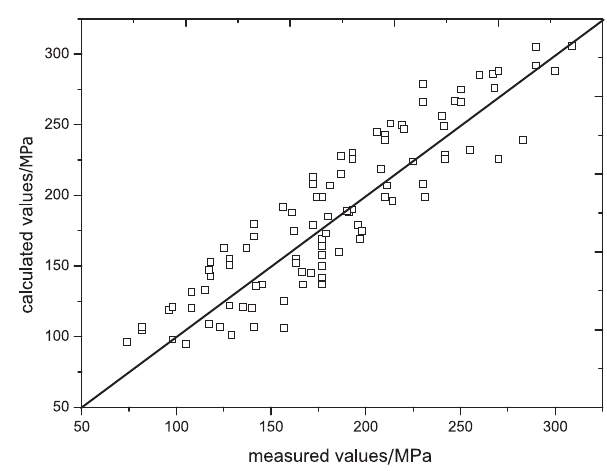
Fig. 3: Comparison between measured values and calculated values of R m